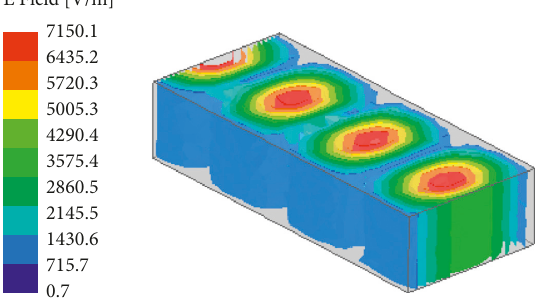
Figure 3: Electric field distribution in the rectangular waveguide.